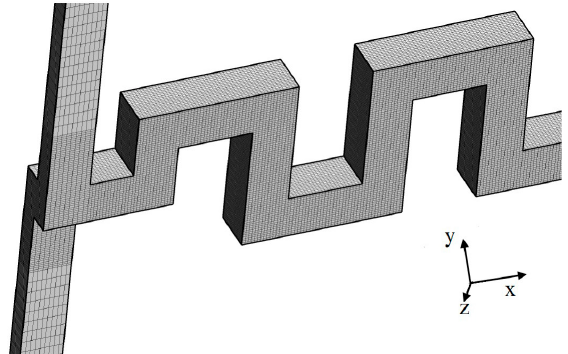
Figure 3. An example of hexahedral grid system.